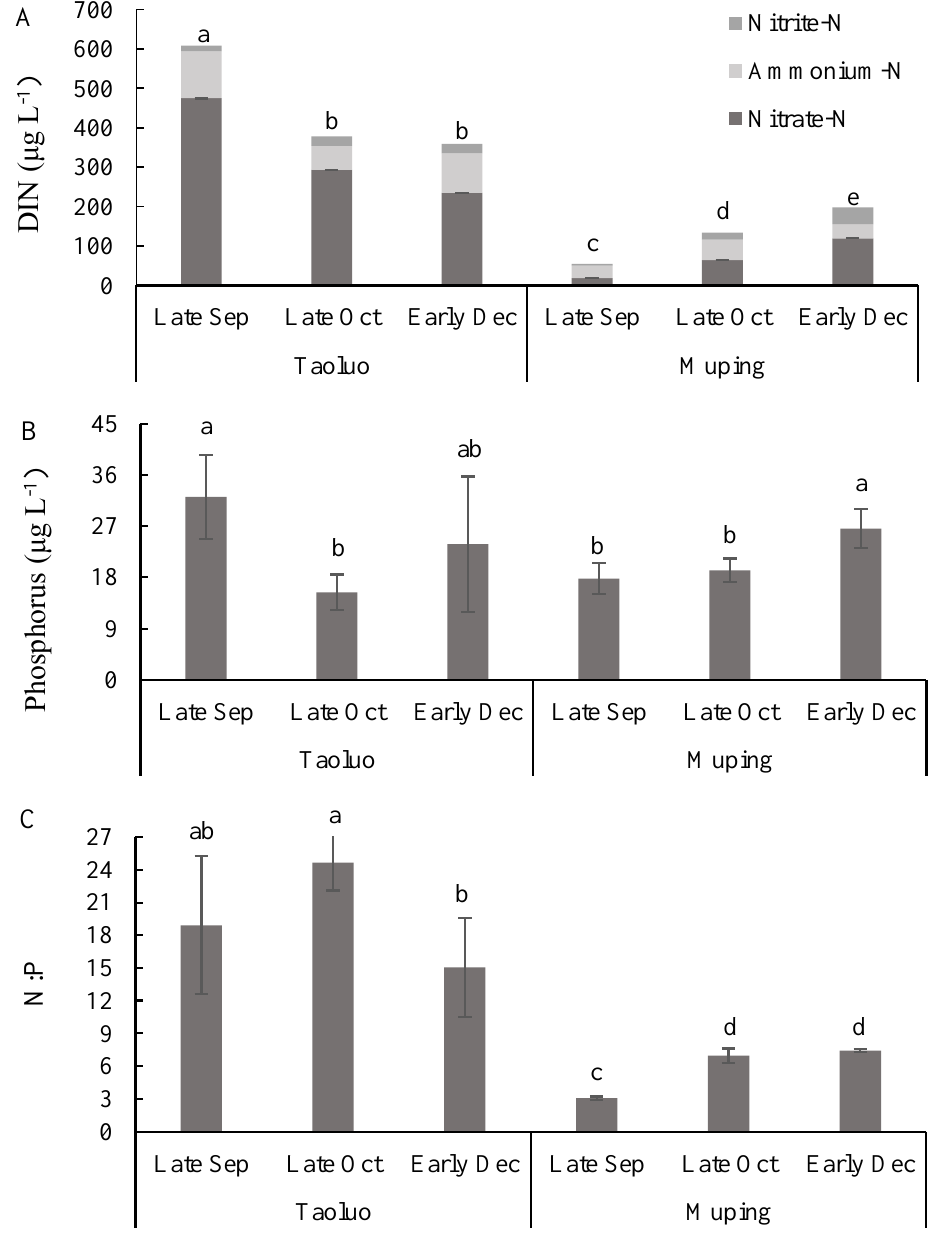
Figure 3. The concentrations of dissolved inorganic nitrogen (DIN: NO 3 -N, NH 4 -N, NO 2 -N) ( A ) and phosphorus (PO 4 -P) ( B ), and N:P (the ratio of DIN to phosphorus) ( C ) in Taoluo and Muping laver farming area in September (Sep), October (Oct), and December (Dec). The different letters in each row shows that the values are significantly different ( p < 0.05). 3.3. The Content of the Nutrient Composition in the Varying Laver Species/Strains That Were Cultured in Taoluo and Muping The mean contents of sugar accounted for 17.32–28.47% of the dry weight (Table 1). Sugar content was the highest in TlPh in late Sep and the lowest in MpPyC in early Dec. For the same strains, there was no statistically significant difference between the two farming regions (TlPh vs. MpPh in late Sep, TlPyA vs. MpPyA in early Dec). The sugar contents of N. haitanensis decreased significantly from late Sep to Oct ( p < 0.05). There were significant difference among the different N. yezoensis strains (MpPyB, MpPyC, MpPyD) cultivated in the same